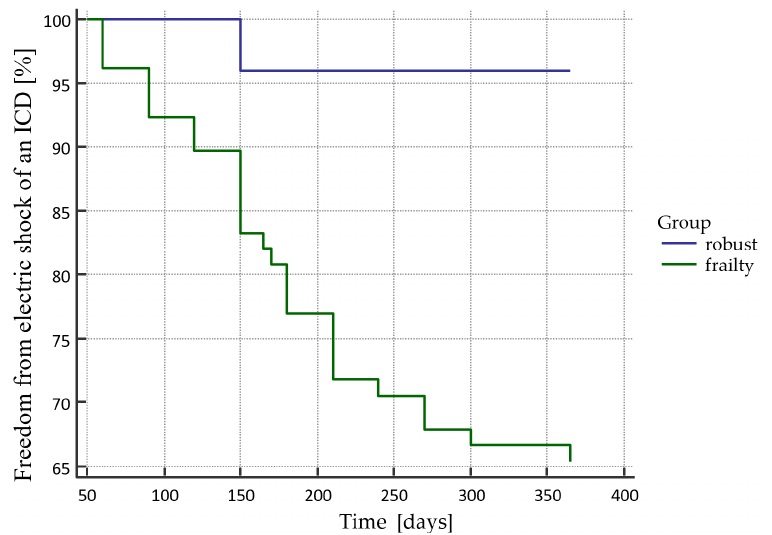
Figure 3. Freedom from an electric shock of an ICD in the Kaplan–Mayer curves according to the presence of frailty.